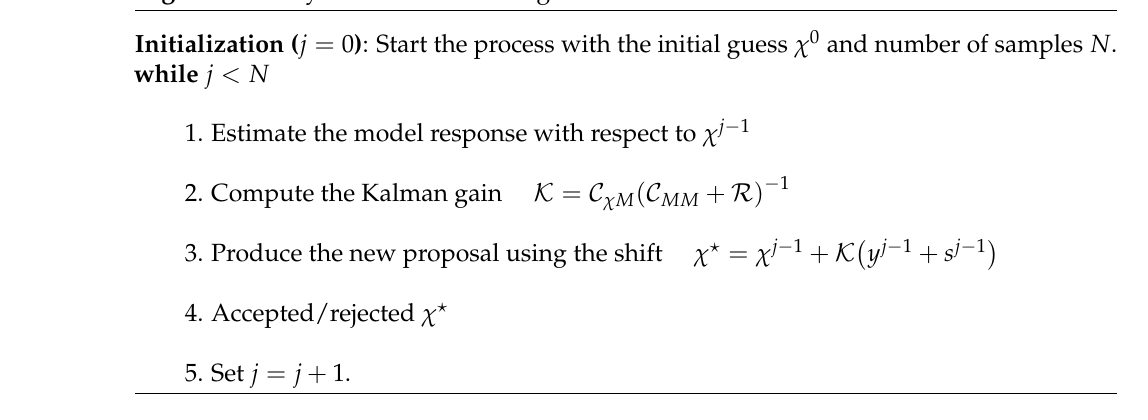
Algorithm 2 Bayesian inference using EnKF-MCMC